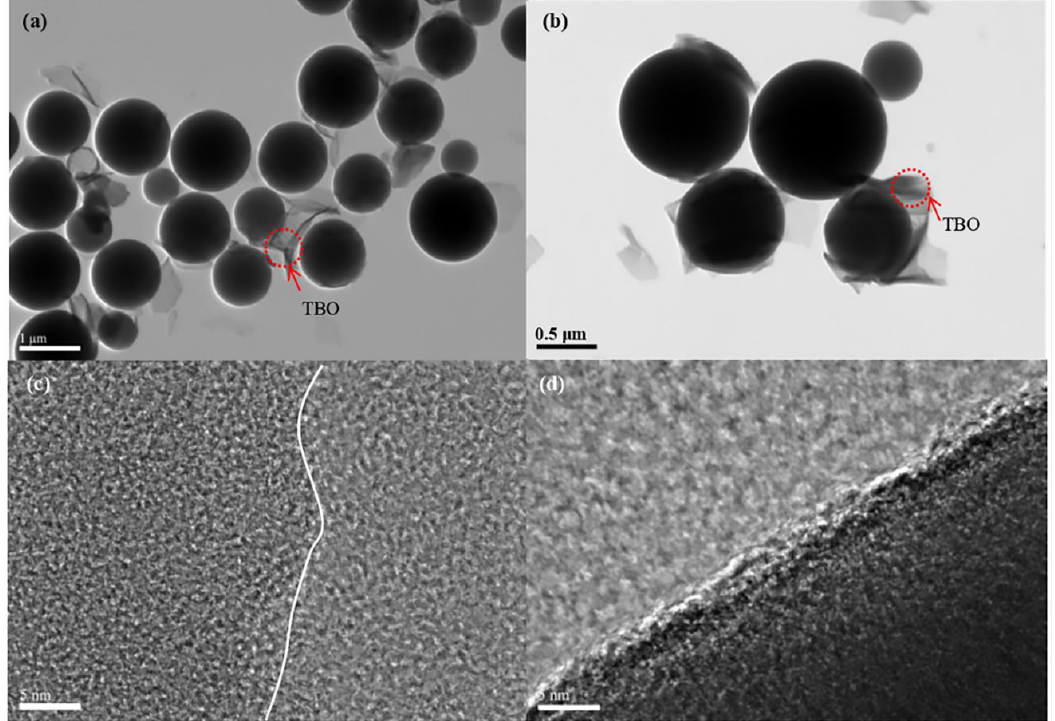
Figure 4. TEM images of 15% P-SSCN: ( a ) TEM images with a scale of 1 μm, ( b ) TEM images with a scale of 0.5 μm, ( c ) and ( d ) TEM images with a scale of 5 nm.